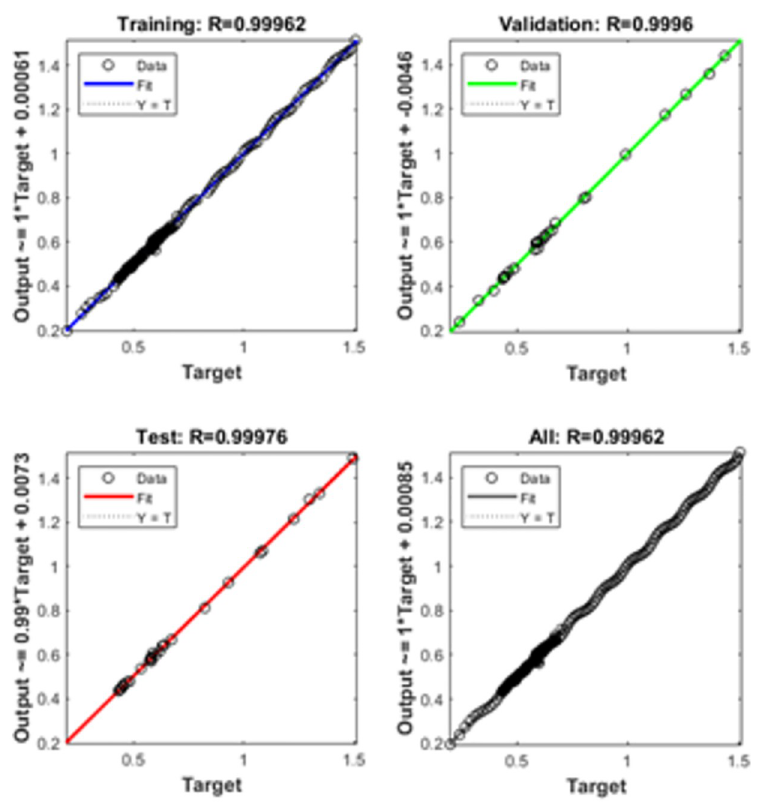
Fig 7. Regression actions for solving the infection FONPPS of Case